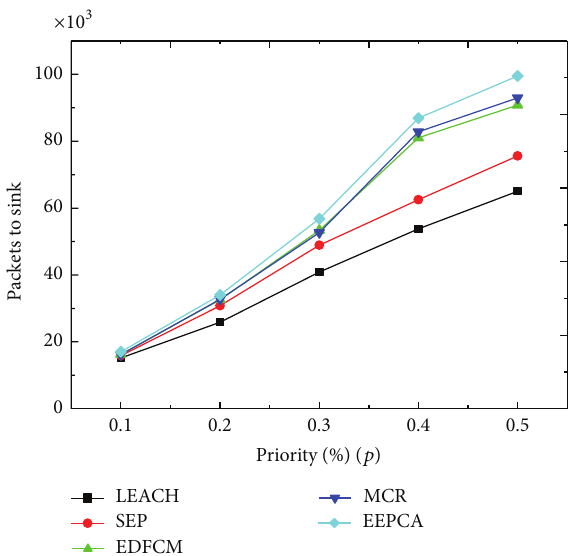
Figure 15: Lifetime of the whole